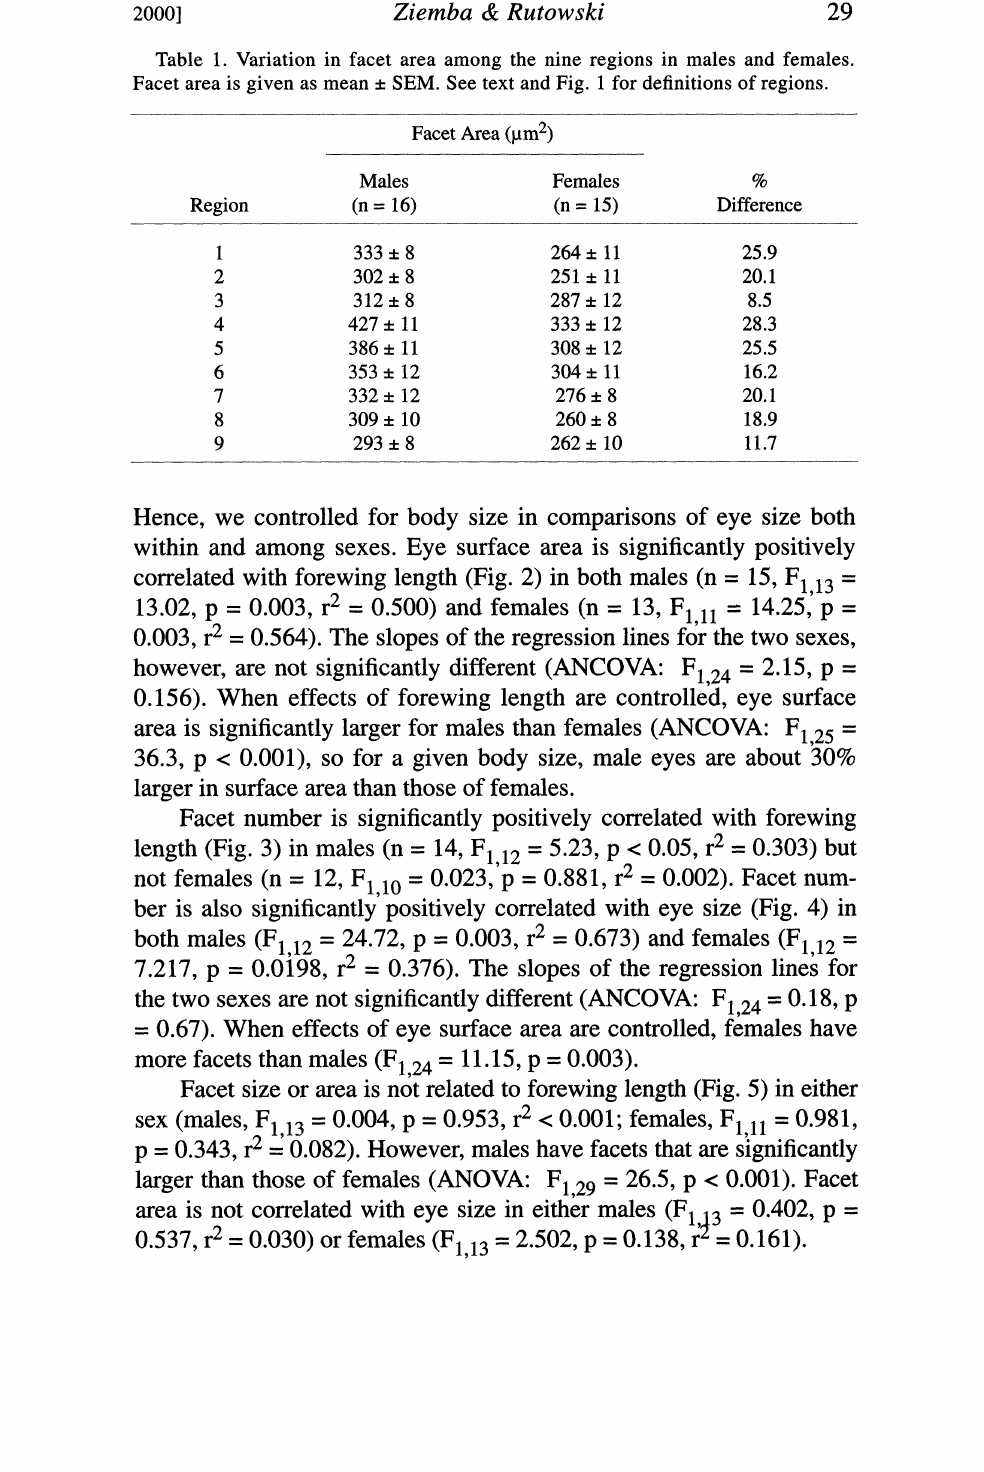
Table 1. Variation in facet area among the nine regions in males and females. Facet area is given as mean +/- SEM. See text and Fig. for definitions of